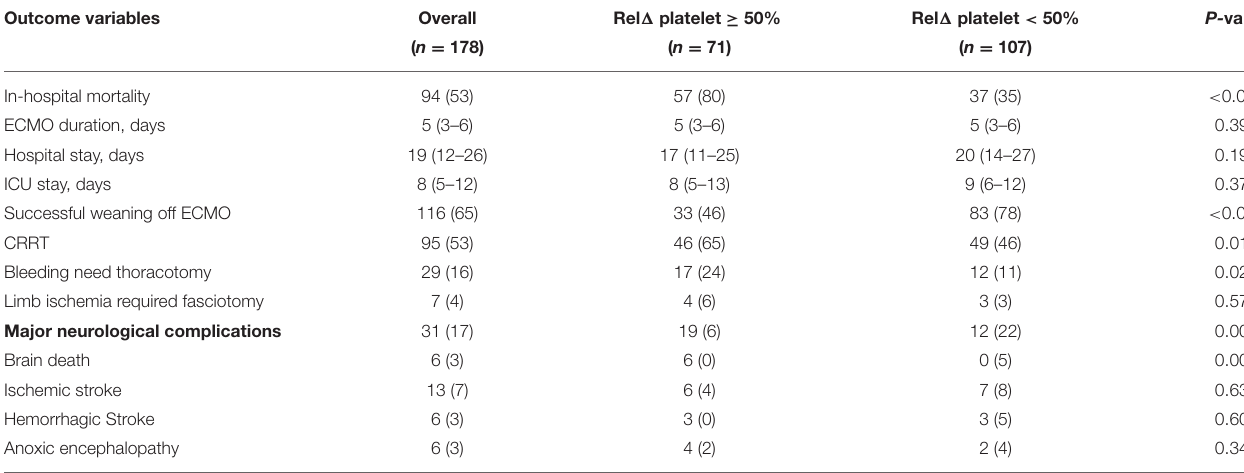
TABLE 2 | Outcomes.